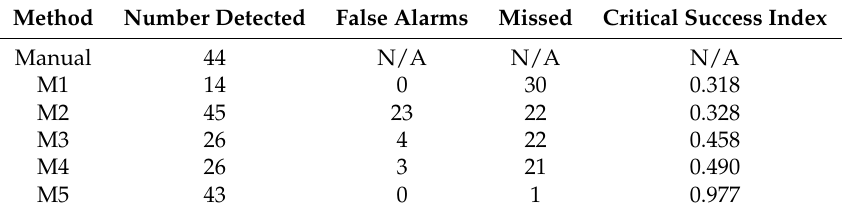
Table 3. Comparison of the five go-around detection methods to a manual analysis of 12 days of aircraft data at